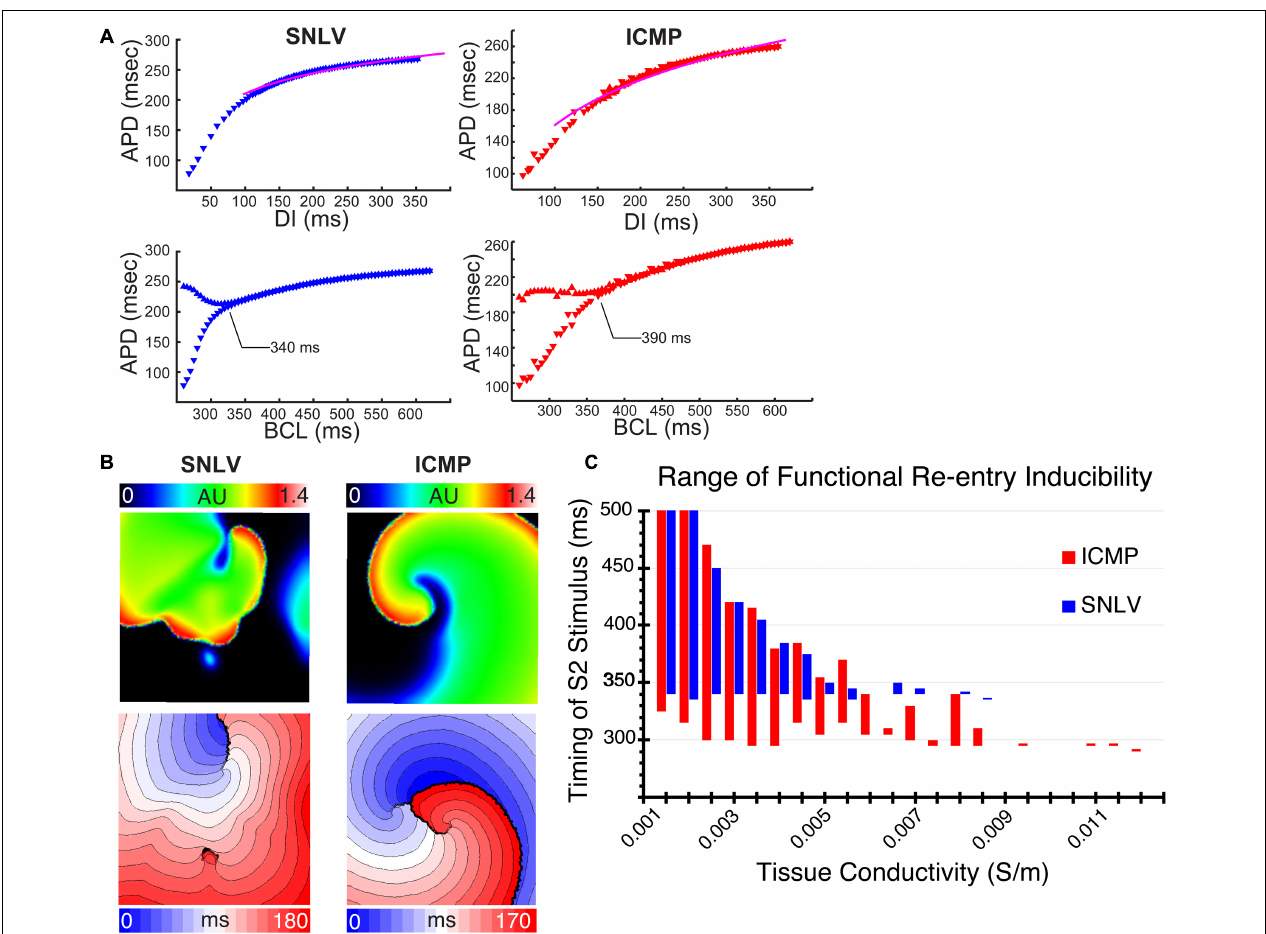
FIGURE 3 | (A) Cell-level simulations of the best-fit GA-derived SNLV (blue) and ICMP (red) model. The first row demonstrates the APDR. The pink line is the patient derived average APDR curve. These plots demonstrate good fit of the models to patient data. The second row demonstrates bifurcation plots for SNLV and ICMP models. The onset of APD alternans (development of bifurcation) is annotated. APD alternans occur at slower cycle lengths in the ICMP model compared to SNLV suggesting a more proarrhythmic behavior. (B) Tissue-level simulation using a conductivity of 0.009 S/m and S1S2 interval of 330 ms for the SNLV model and 295 ms for the ICMP model. Non-sustained functional re-entry was induced in the SNLV model while sustained functional re-entry was induced in the ICMP. Upper row: snapshot of the simulation, color represents transmembrane voltage in arbitrary units. Lower row: activation isochrone maps for simulations using SNLV and ICMP models; each isochrone represents 10 ms. (C) Range of functional re-entry inducibility of the SNLV (blue) and ICMP (red) best-fit models. X-axis represents different tissue conductivity values in Siemens/m and Y -axis represents S1S2 coupling intervals that resulted in sustained functional re-entry. The best-fit ICMP model has a wider range of S1–S2 intervals, for all conductivity values, that result in sustained functional re-entry suggesting a more proarrhythmic